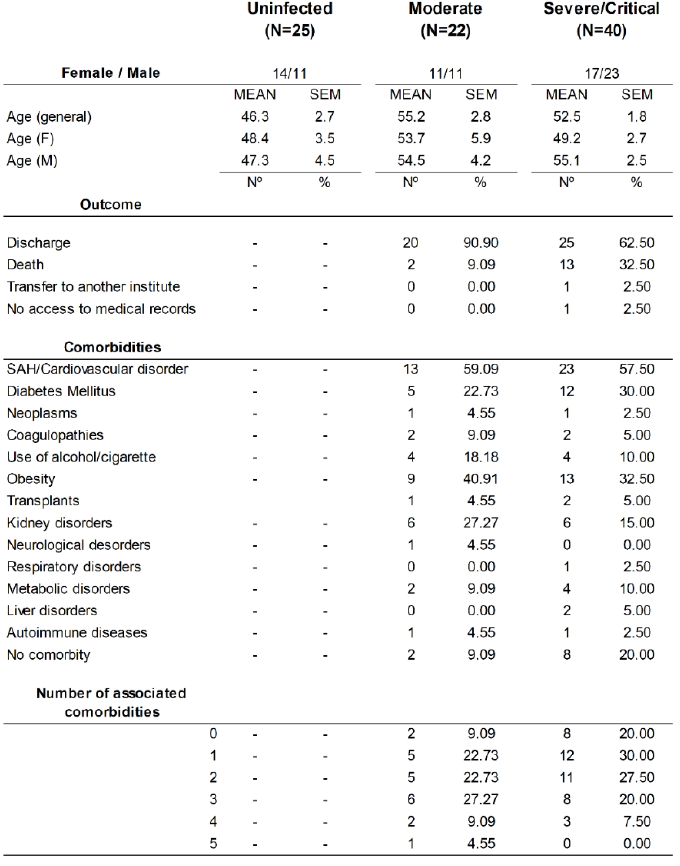
Figure 1. Demographic data of patients affected by SARS-CoV-2 and uninfected individuals. Data on age, outcome, and comorbidities of uninfected individuals and patients with COVID-19 (moderate and severe/critical): M—male; F—female; N—sample number; and SAH—systemic arterial hypertension.